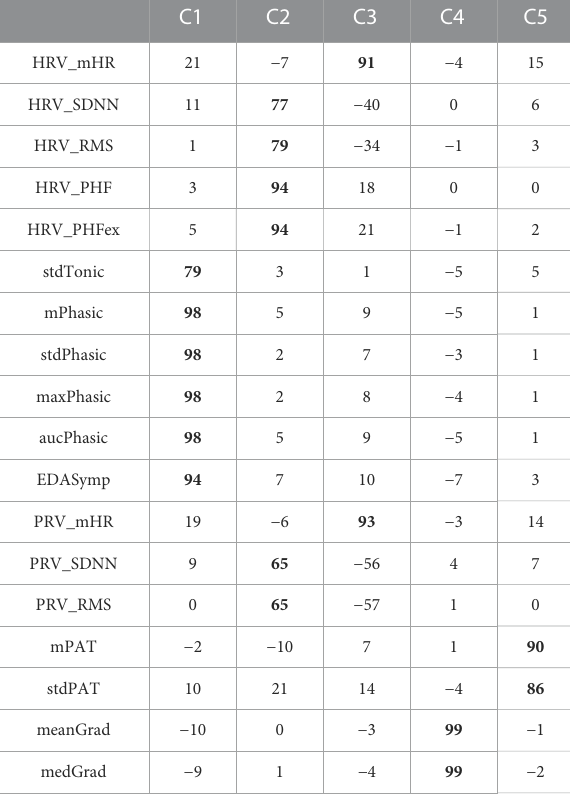
VAR, Prop: Percentage of Total Variance Explained by Component. Bold text indicates values >